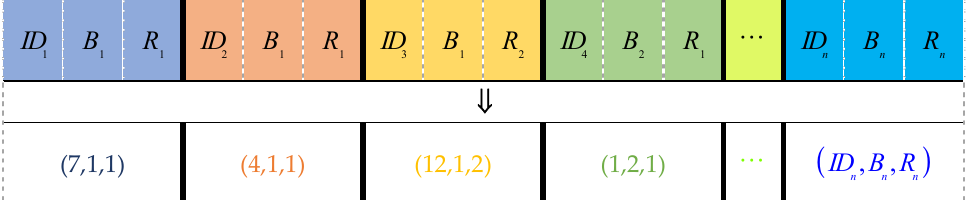
Yard container Ship container Voluntary shift Figure 6. Flow chart of the CSPP. 4.3. Heuristic Rules for Relocation of Yard Containers